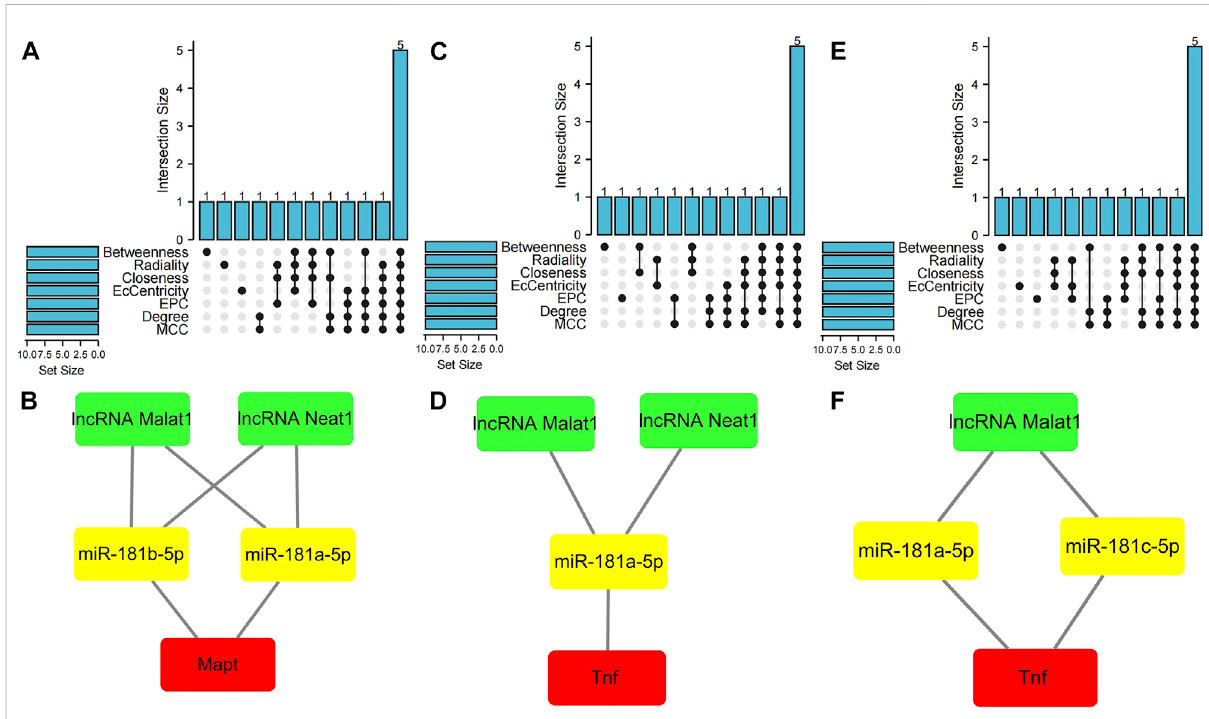
FIGURE 6 Hub gene analysis of three programmed cell death (PCD)-related ceRNA regulatory networks. (A) Hub nodes in the apoptosis-related ceRNA regulatory network that were shared by seven different algorithms. (B) Key ceRNA regulatory pathways for apoptosis-related ceRNA regulatory network. (C) Hub nodes in the necroptosis-related ceRNA regulatory network that were shared by seven different algorithms. (D) Key ceRNA regulatorypathwaysfornecroptosis-relatedceRNAregulatorynetwork. (E) Hubnodesinthepyroptosis-relatedceRNAregulatorynetworkthat were shared by seven different algorithms. (F) Key ceRNA regulatory pathways for pyroptosis-related ceRNA regulatory network. Red color denotes differentially expressed programmed cell death (PCD)-related genes, yellow color denotes miRNAs, and green color denotes